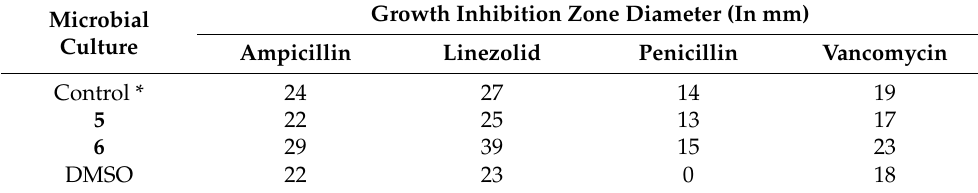
Table 3. Antibiotic susceptibility testing of E. faecium E5 strain cultured in the presence of compounds 5 and 6 tested at a subinhibitory concentration of 250 µ g/mL and of dimethyl sulfoxide (DMSO) (growth inhibition zone diameters were measured in mm).